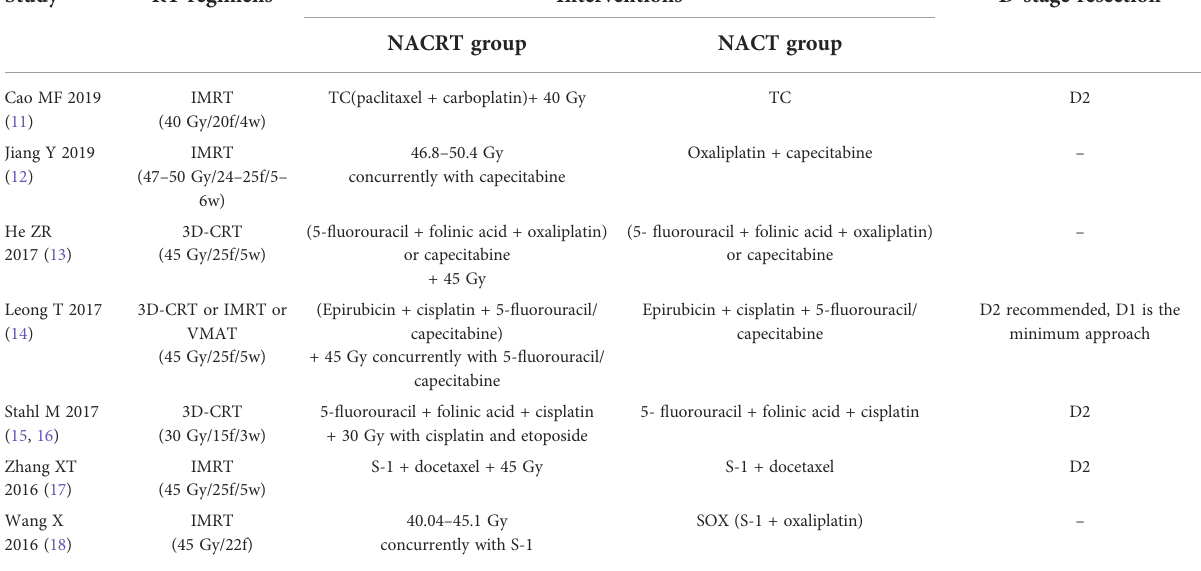
TABLE 2 Therapeutic regimen of studies enrolled.